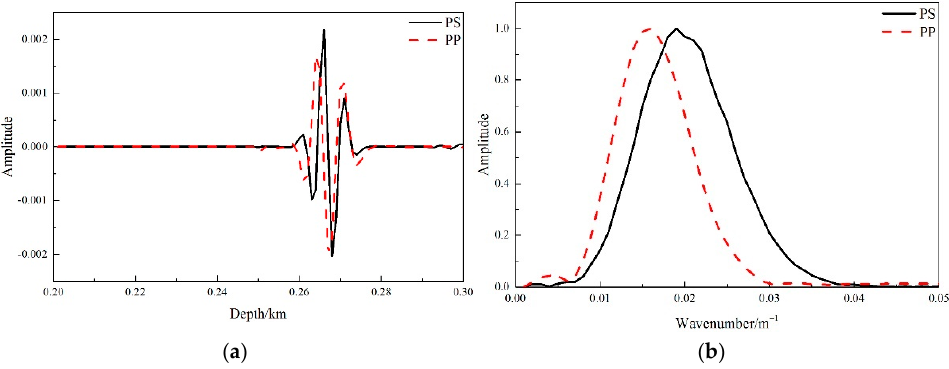
Figure 9. Comparison between PP and PS images: ( a ) Single-channel data; ( b ) Wavenumber spec- trum.